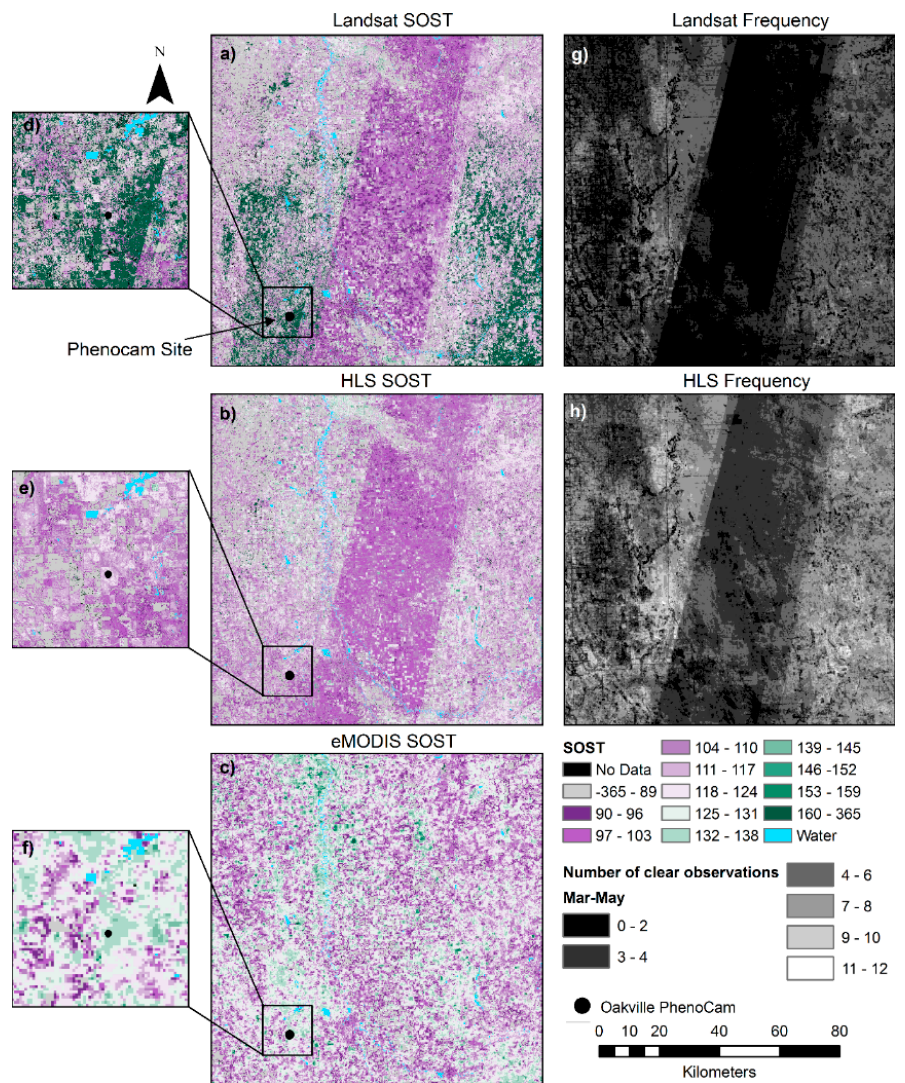
Figure 3. Spatial distribution of SOST based on Landsat-8, HLS, and eMODIS datasets.